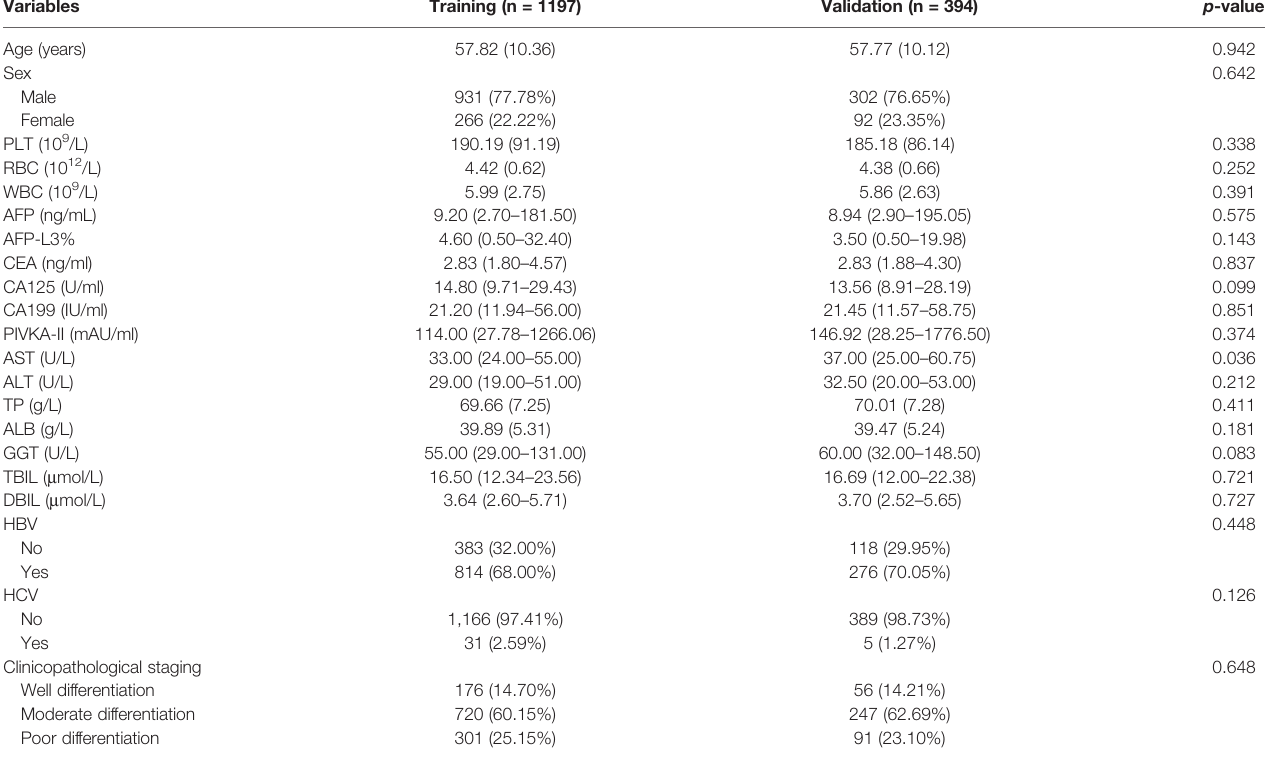
TABLE 1 | Baseline characteristics of the development and validation